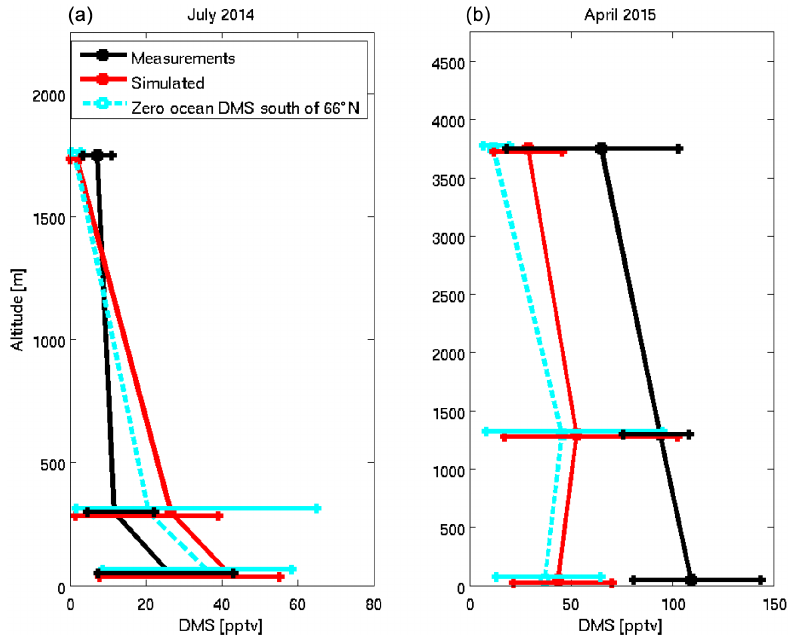
Figure 5. The campaign-mean vertical profile of DMS from the GEOS-Chem simulation (red line) and measurements (black line) for July 2014 and April 2015. Simulations for zero ocean DMS at latitudes south of 66 ◦ N (SimZeroBelow66) are shown as cyan dashed line. The 20th and 80th percentiles are shown by horizontal